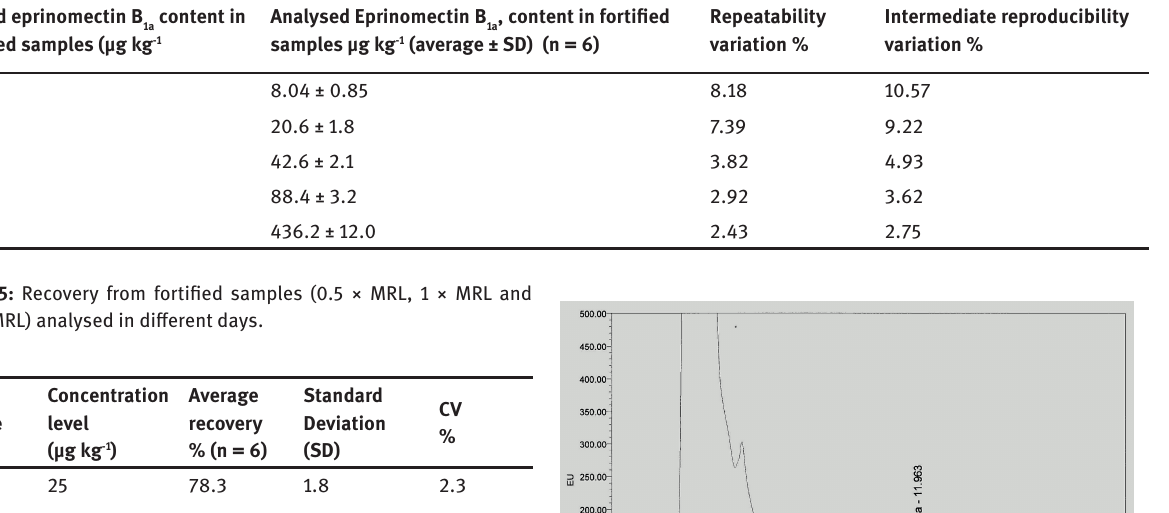
Table 4: The precision of the analysis in bovine samples.